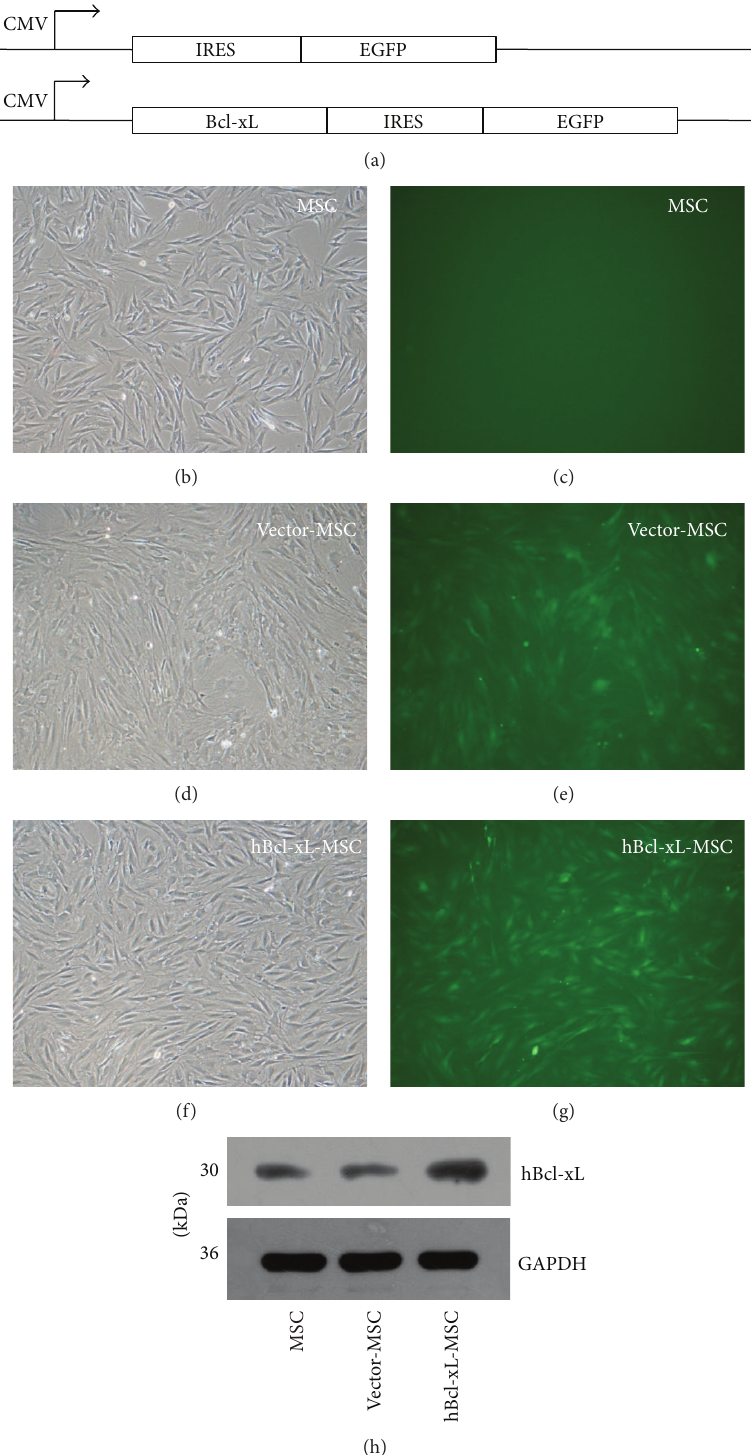
Figure 1: Expressions of EGFP and hBcl-xL in rat bone marrow MSCs. (a) Schematic representation of the coding regions of the viral vectors pLenti6.3-IRES-EGFP and pLenti6.3-hBcl-xL-IRES-EGFP. In vector pLenti6.3-hBcl-xL-IRES-EGFP, the insertion of IRES could lead to the individual expression of EGFP together with the expression of hBcl-xL in the transduced cells. All expressions were driven by CMV promoter. ((b)–(g)) Expressions of EGFP in wild type MSCs ((b) and (c)), vector-MSCs ((d) and (e)), and hBcl-xL-MSCs ((f) and (g)). (h) Western blot analysis of the expressions of hBcl-xL in MSCs, vector-MSCs, and hBcl-xL-MSCs. Data are representative of three independent